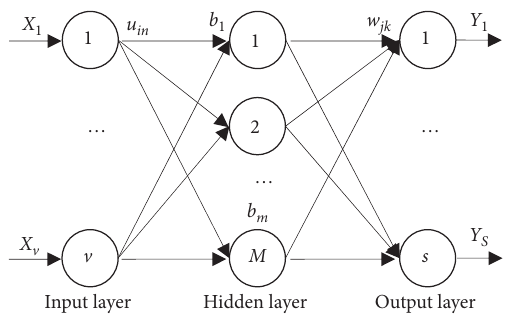
Figure 1: The structure diagram of